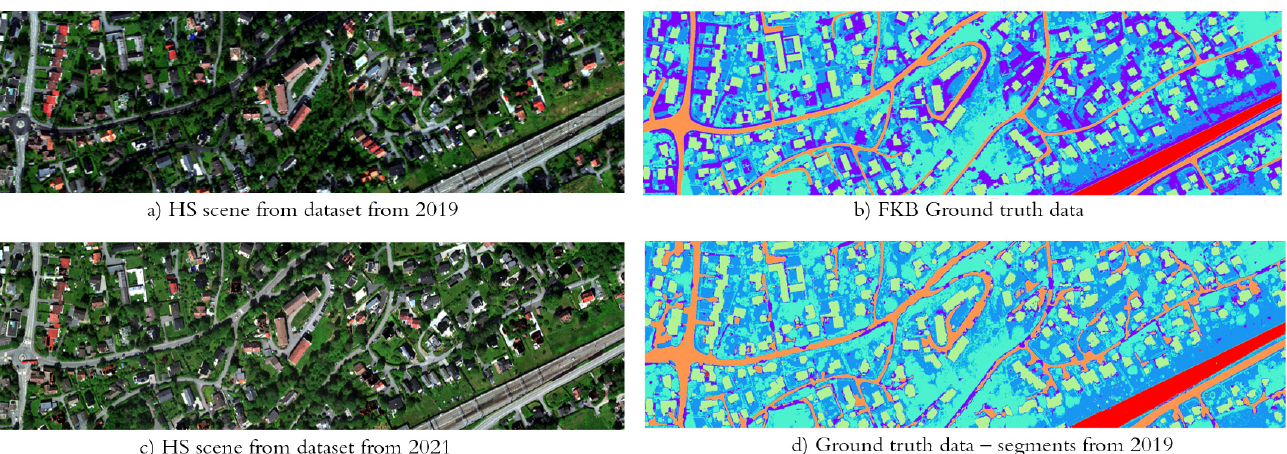
Table 2. Segmentation results without data augmentation for the dataset from 2019 and 2021 for the ResU-Net model based on MCC calculated for each class (the range scales from − 1 to 1) and overall F1 score (the range scales from 0 to 1).